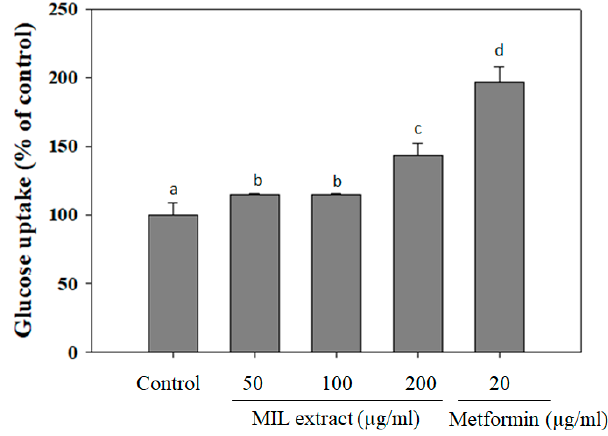
Figure 3. Glucose uptake capacity of M. indica leaves (MIL) extract in human hepatic LO-2 cells. LO-2 cells were incubated with the extract for 48 h before replacing the spent culture medium by incubation buffer (Phosphate-buffered saline (PBS), 0.1% bovine serum albumin (BSA) and 8 mM glucose). The mixture was further incubated for 3 h and the glucose concentration in